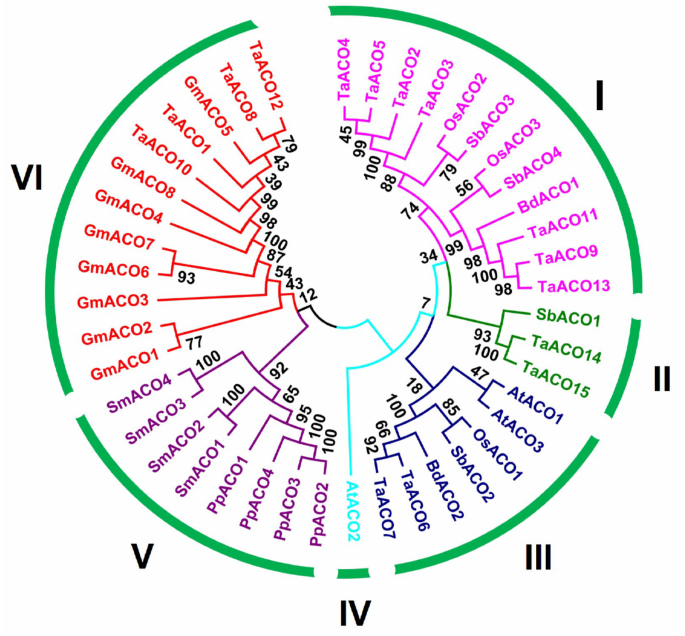
Figure 1. Phylogenetic analysis of ACO proteins among the rice (3) wheat (15), Arabidopsis (3), soybean (8), Brachypodium (2), Sorghum (4), Physcomitrella (4), and Selaginella (4) using the MEGAX by the neighbor-joining (NJ) method and the bootstrap was 1000